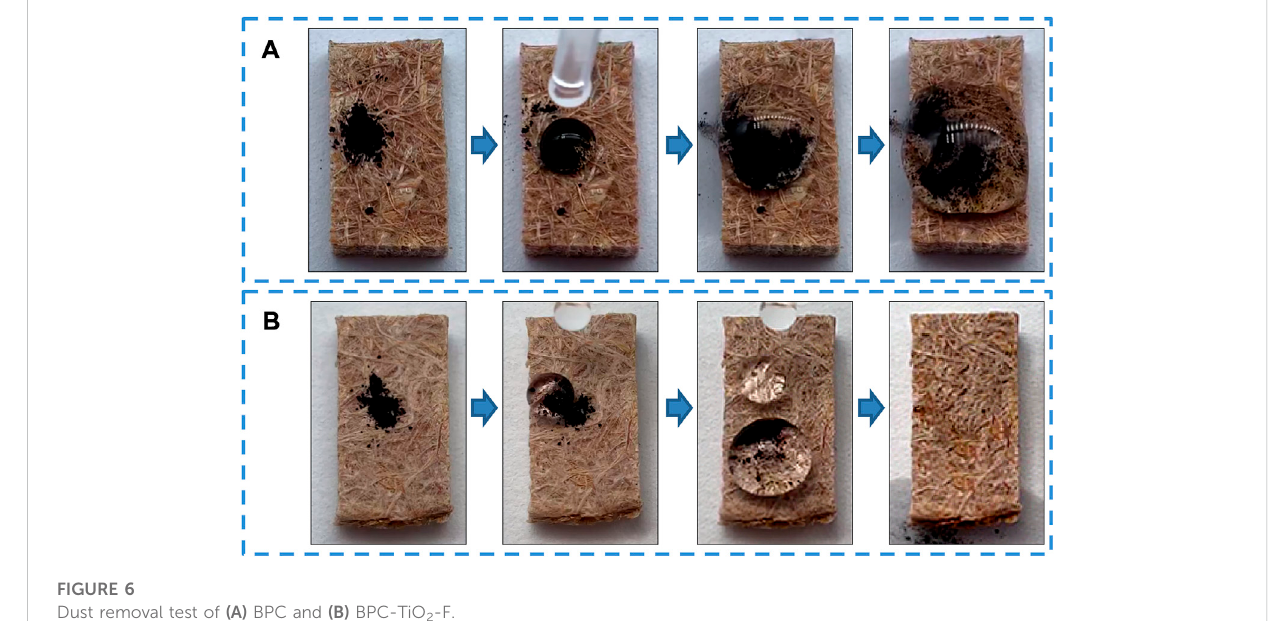
FIGURE 7 Anti-mold effect of (A) BPC and (B) BPC-TiO 2 -F.